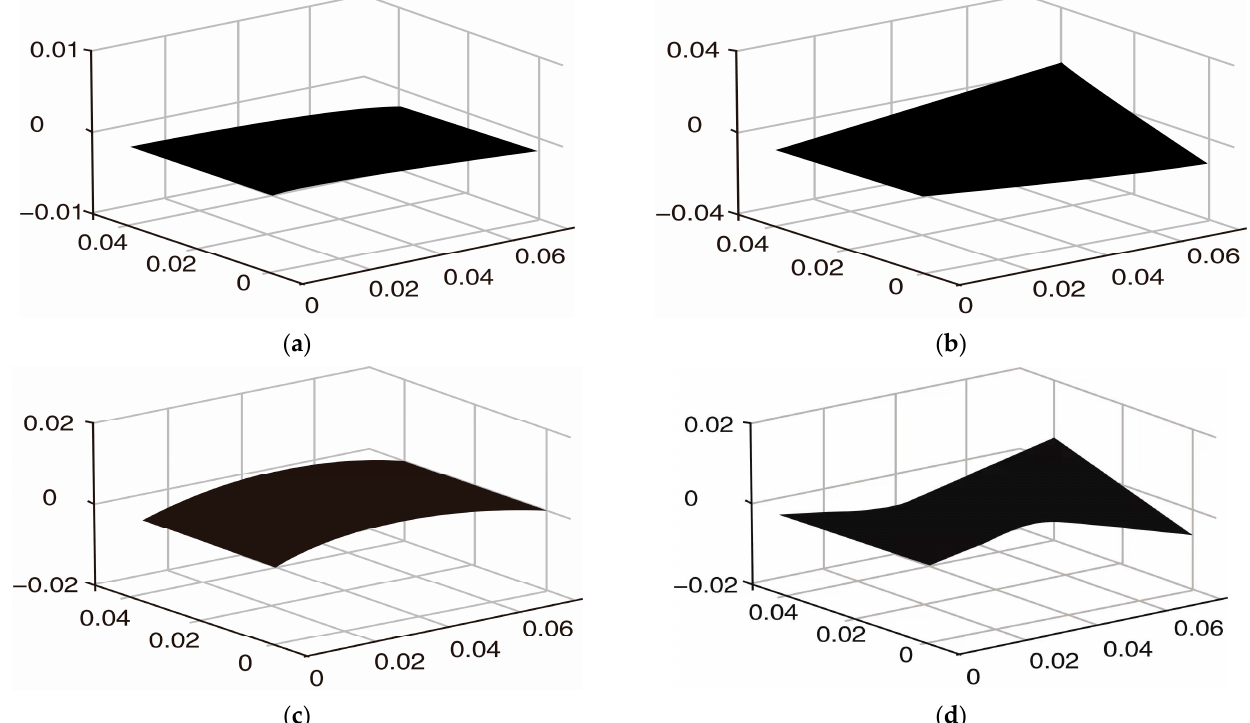
Figure 8. The first four modal shapes of cantilever plate (Matlab numerical solution). ( a ) First-order bending mode; ( b ) second-order torsional mode; ( c ) third-order bending mode; ( d ) fourth-order torsional mode.